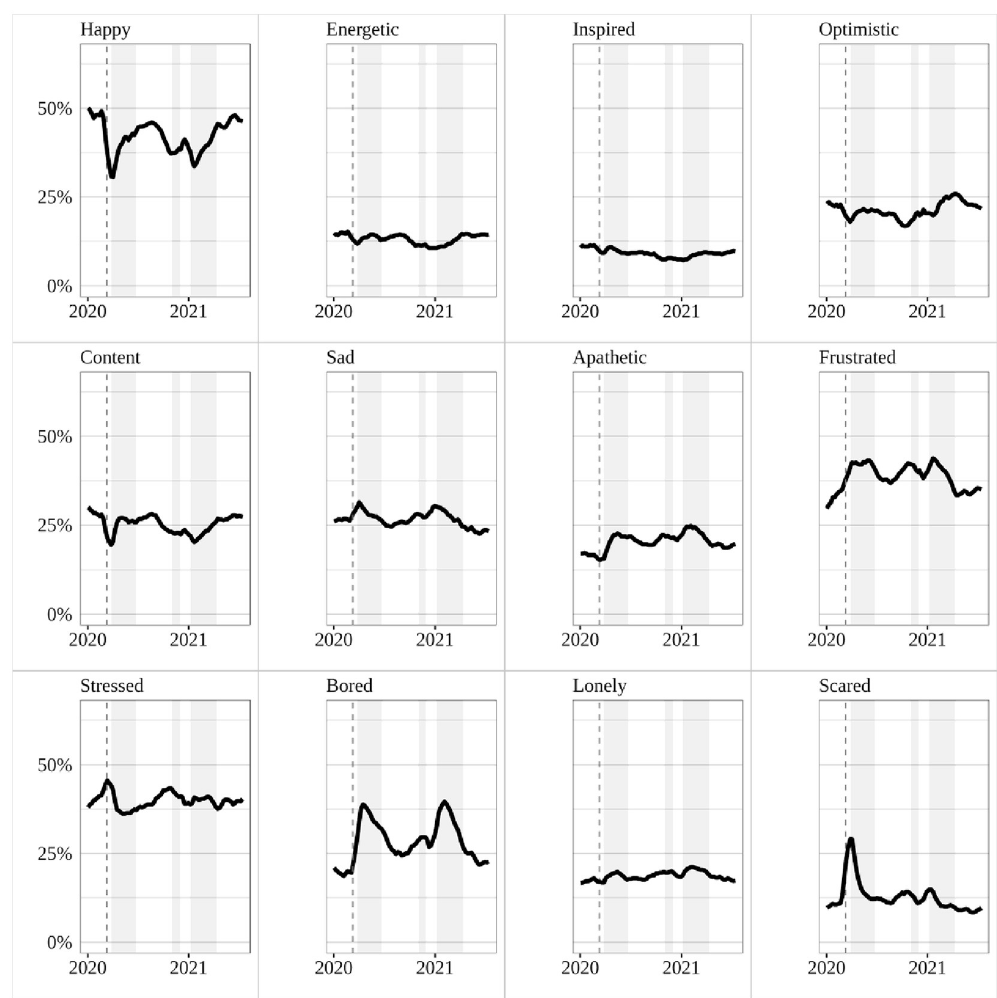
Fig 1. YouGov mood tracker, 2019–2021: Descriptive trends. Mean scores by week; rolling averages. The start of the pandemic is indicated by the dashed lines, while lockdown periods are indicated by the shaded portions on charts. Source: